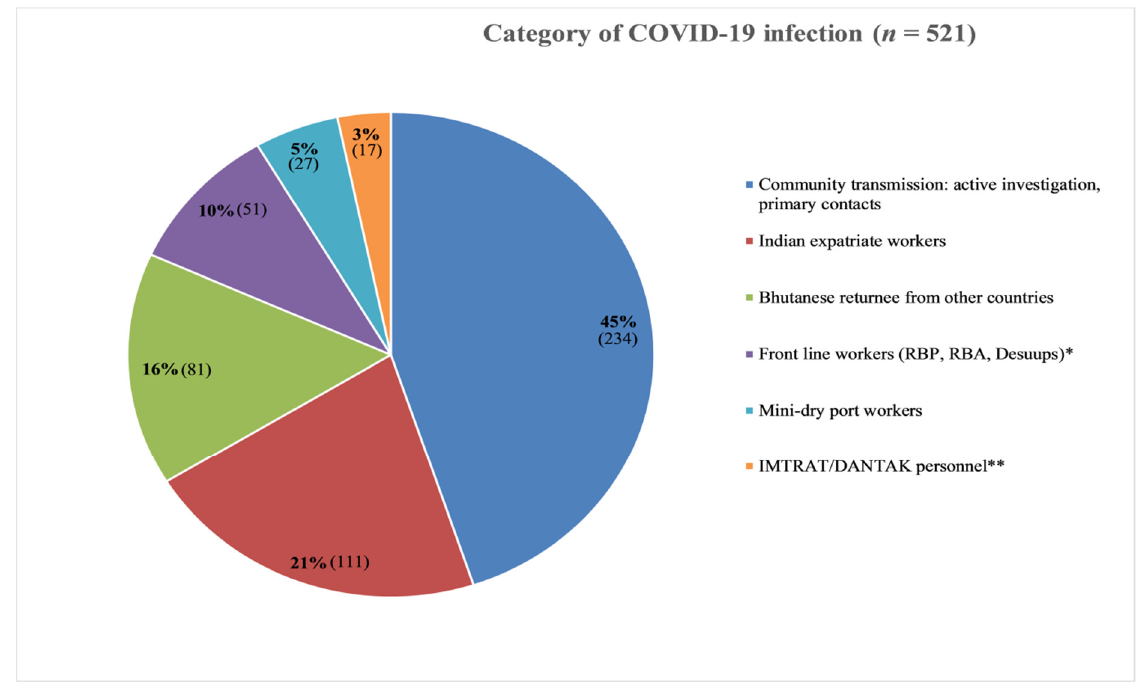
Figure 2. Categories of those infected with COVID-19 in Phuentsholing, Bhutan until 31 May 2021. * RBP- Royal Bhutan Police, RBA- Royal Bhutan Army, Desuups - volunteers. ** IMTRAT-Indian Military Training Team and DANTAK- Border Road